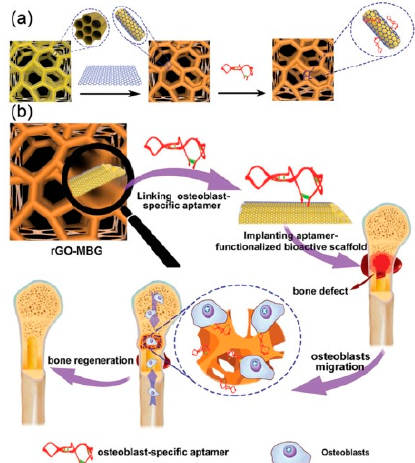
Figure 6. Schematic illustration of mesoporous bioactive glass (MBG) scaffold coated with reduced graphene oxide (rGO) and conjugated with osteoblast-specific aptamer [228]. Reproduced with permission from the cited reference.